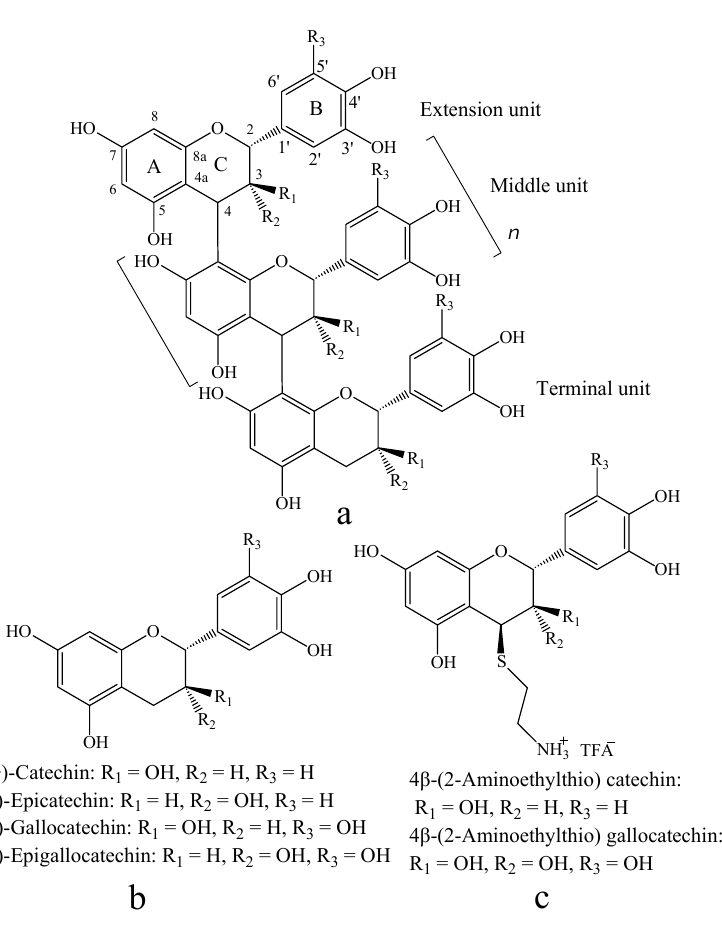
Figure 1. Structures of proanthocyanidins polymer (a), monomeric flavan-3-ol (b), and their aminomethylthio derivatives